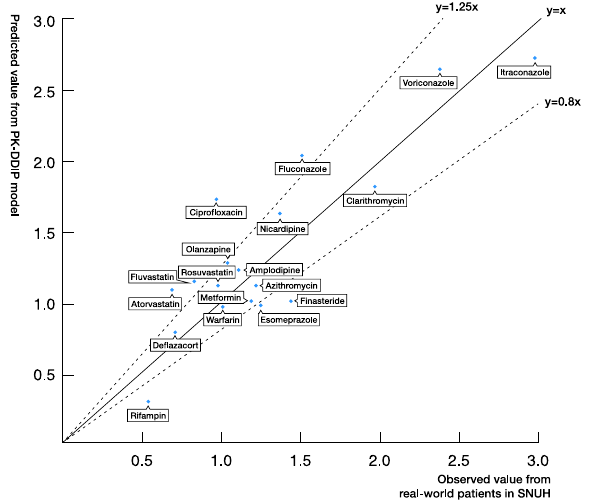
Fig. 3 Comparison with real patients ’ result. The comparison of pharmacokinetic drug-drug interaction prediction (PKDDIP) model results (predicted fold change values) and observed real-world patients ’ results using tacrolimus as a victim drug in a tertiary hospital clinical data warehouse. SNUH, Seoul National University